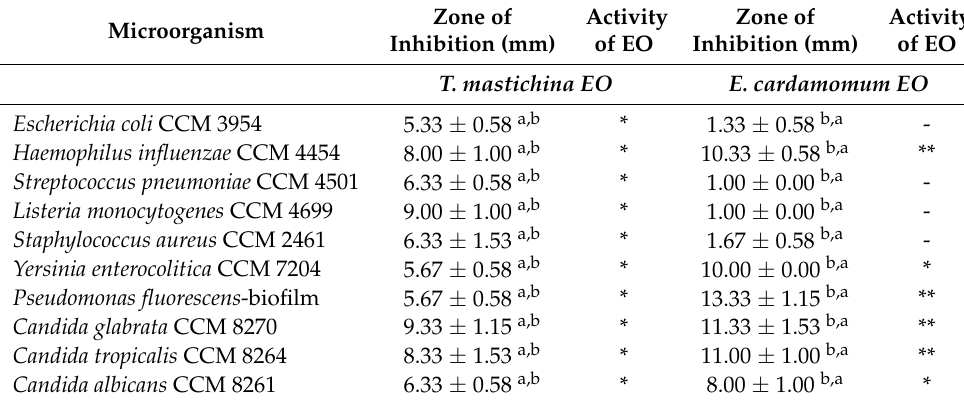
Table 5. Disc diffusion method.